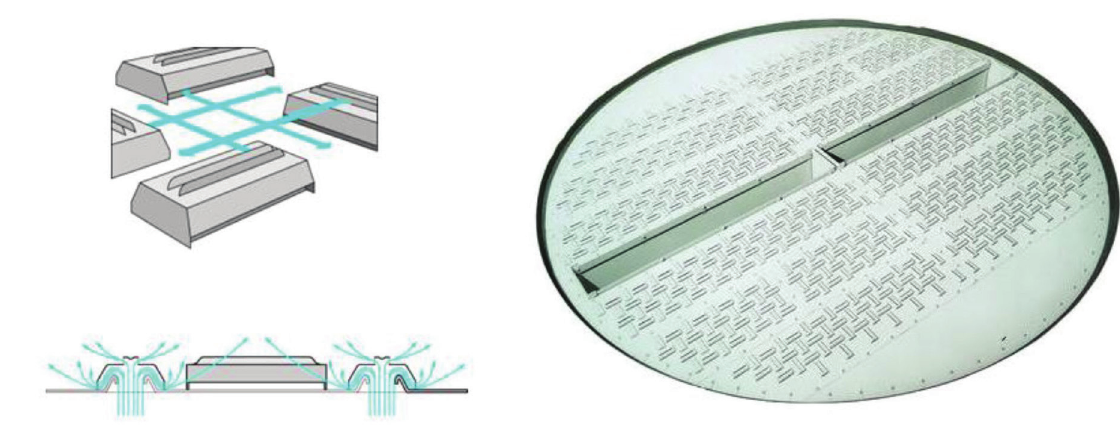
Fig. 3 – Photograph of a two-pass KSG tray with inserted sketches indicating vapour flow